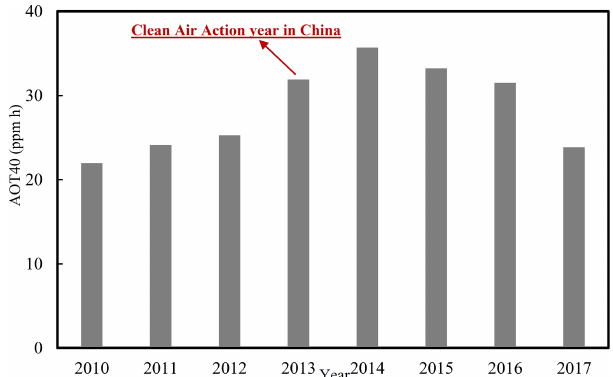
Figure 2. The national annual accumulated AOT40 values in China from 2010 to 2017. The unit is